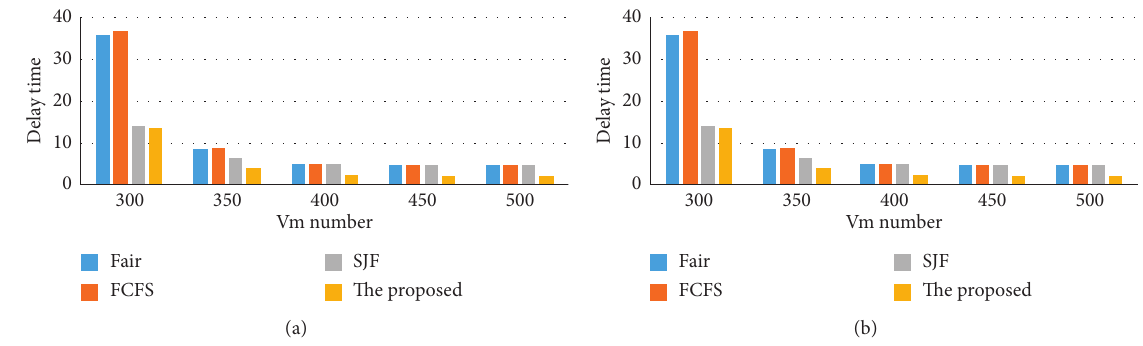
Figure 6: Results of experiment 1. (a) Comparison of average task delay. (b) Comparison of average task priority. Table 3: Average delay time of different algorithms on different size of virtual machine clusters (in seconds). Cluster size